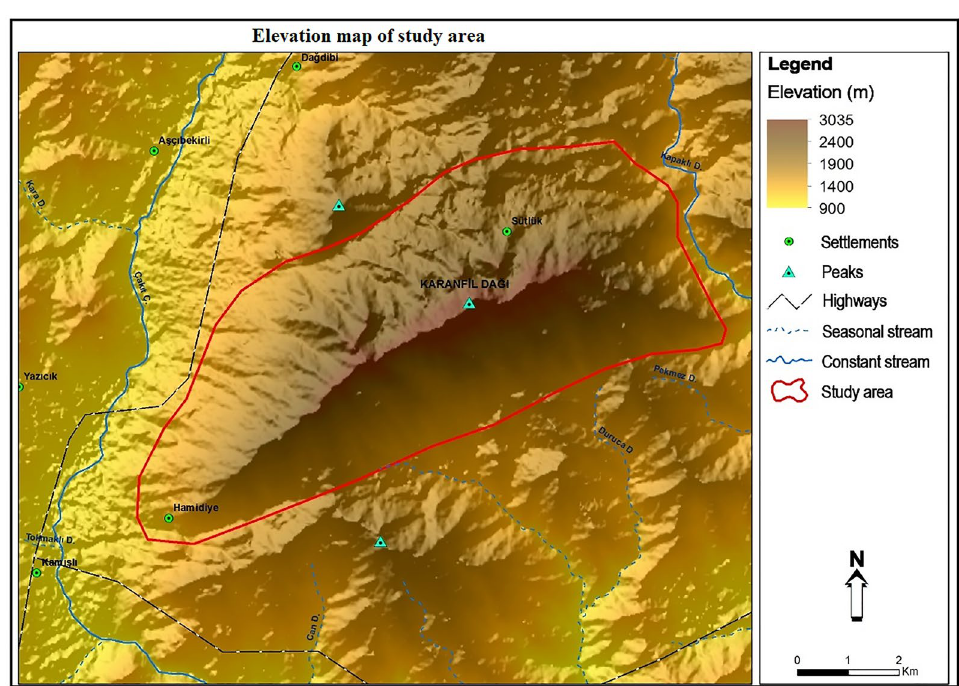
Fig. 11 Elevation map of study